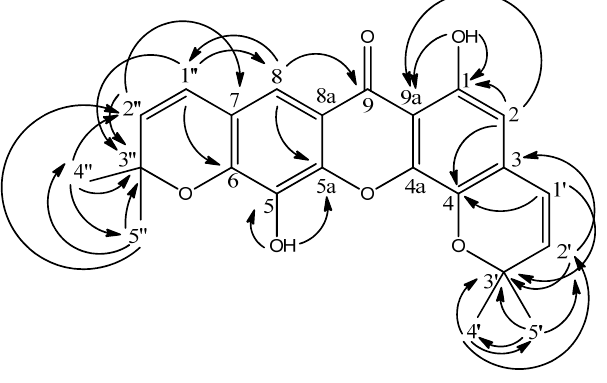
Figure 3. HMBC 2 J and 3 J correlations between 1 H and 13 C in 2